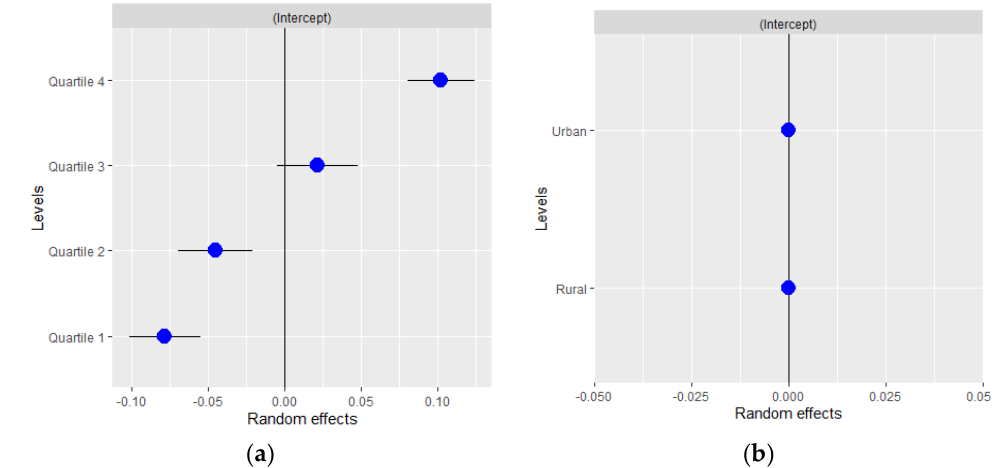
Figure 1. Random effects by ( a ) basic healthcare area deprivation and ( b ) by type of area in women for all the period analyzed.